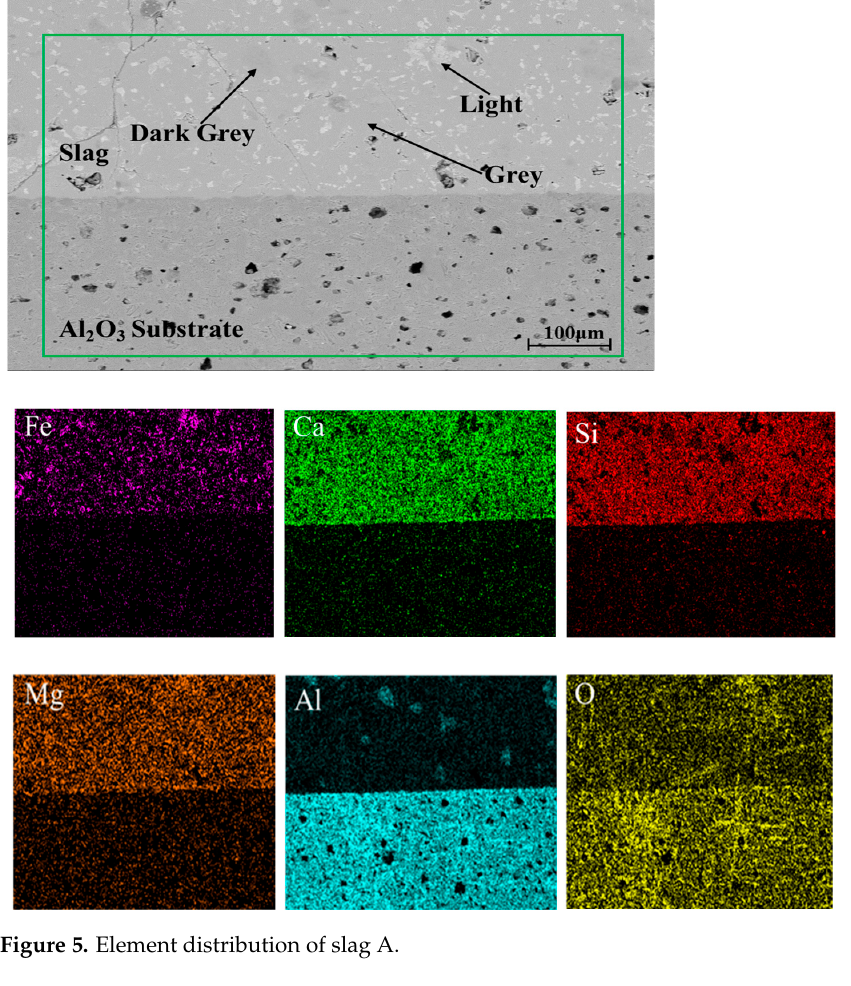
Figure 5. Element distribution of slag A.